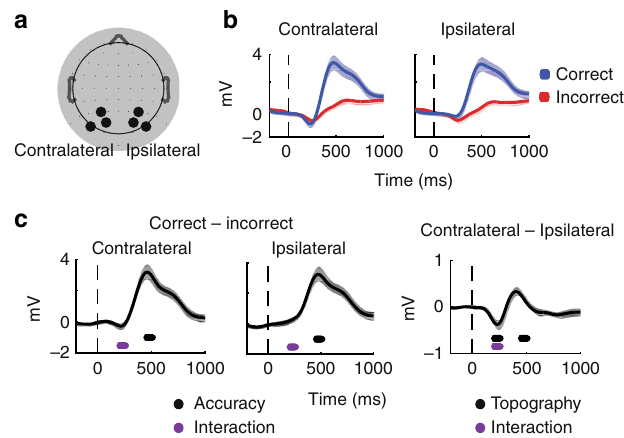
Fig. 2 Event-related potentials con fi rm involvement of perceptual processes. a ERPs on correct (blue) and incorrect (red) trials in the contralateral and ipsilateral electrodes indicated in the topography plot to the right in panel b (note that electrode labels are fl ipped accordingly so that, by convention, electrodes contralateral to the target are shown on the left, see Methods). Dashed vertical line indicates target onset. b Topography for contralateral and ipsilateral electrodes used for all analyses are outlined on the 64 electrode Biosemi electrode scheme used in these experiments. c Difference waves between correct and incorrect trials. The END is more negative in contralateral than ipsilateral electrodes, resulting in a signi fi cant interaction between behavioral performance (correct vs. incorrect) and electrode location (contralateral vs. ipsilateral). Most signi fi cantly, there is a sustained increase in LPD amplitude on correct as compared with incorrect trials in both contralateral and ipsilateral electrodes. Dots below waveforms indicate a signi fi cance difference from zero as obtained from resampled t- tests performed on average amplitudes within the 50 ms time windows indicated by the dot width (210 – 260 and 460 – 510 ms post stimulus for the END and LPD, respectively). Signi fi cant main effects are indicated in black while purple indicates a signi fi cant interaction, all at P =